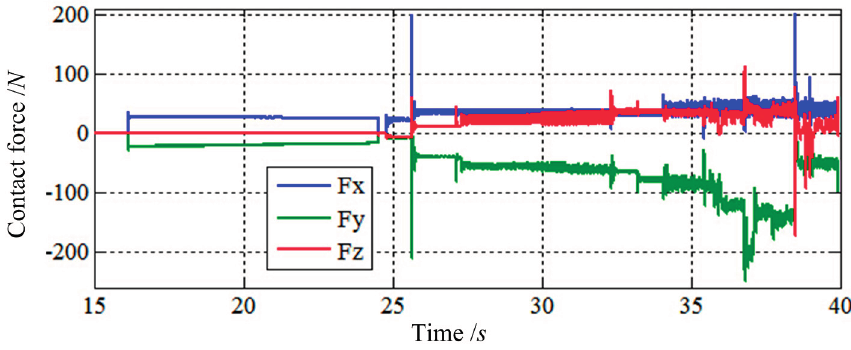
Figure 18. The force tracking results of Case 4.